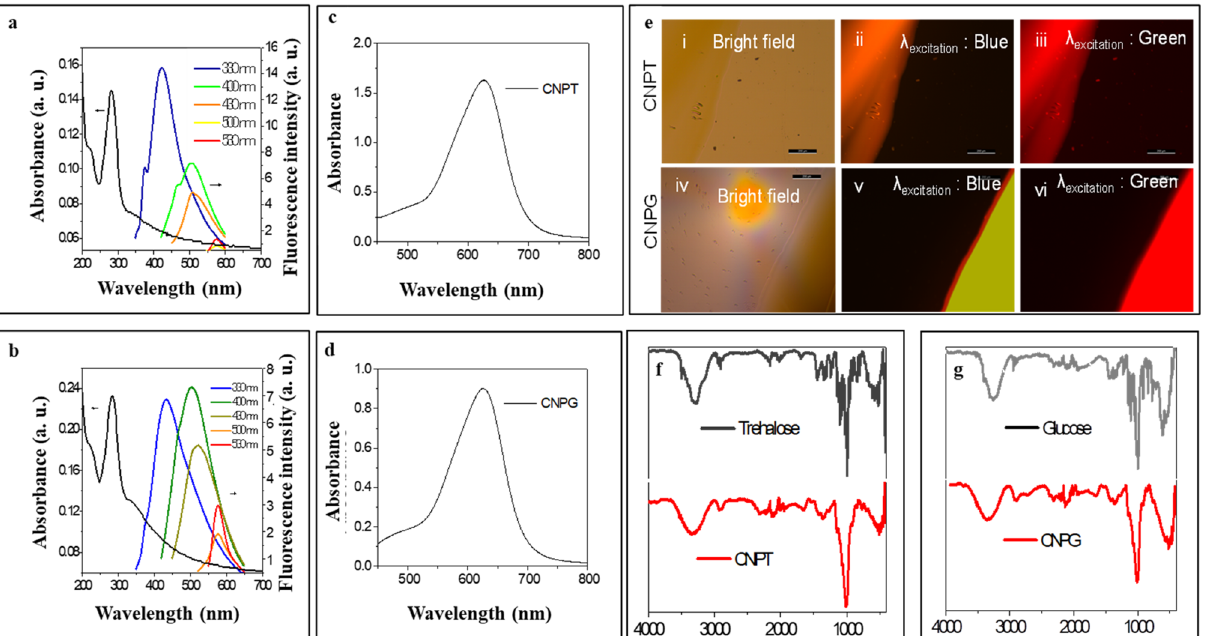
Figure 2. Photophysical properties and surface functionality of carbon-nanodots. ( a ) UV–Vis and fluorescence property of colloidal CNP-trehalose (CNPT), ( b ) UV–Vis and fluorescence property of colloidal CNP-glucose (CNPG); ( c ) Absorbance spectra of CNPT-furfural complex, ( d ) Absorbance spectra of CNPG-furfural complex, ( e ) Emission of CNPT and CNPG film deposited on the glass (i,iv—bright field image, ii,v—emission under blue excitation, iii,vi—emission under green excitation), ( f ) FTIR spectra of CNPT vs molecular trehalose, ( g ) FTIR spectra of CNPG vs molecular